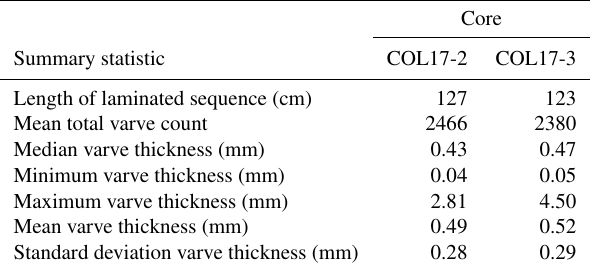
Table 1. Summary statistics based on the average of all observers’ measurements, excluding intervals of indistinct laminations. Total varve counts indicate output of the symmetrical varve-only